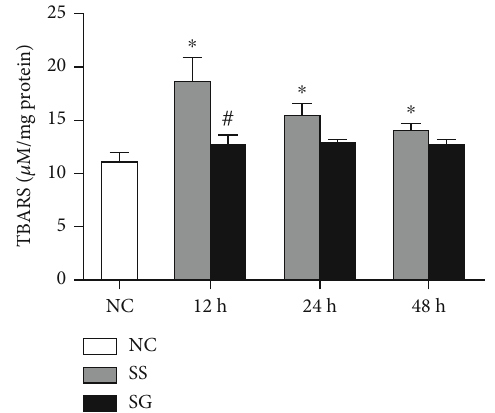
Figure 6: Thiobarbituric acid reactive substance (TBARS) in kidney tissues. NC: normal control; SS: sepsis group with saline; SG: sepsis group with glutamine. Values are expressed as the mean ± SEM . n = 8 for each group at 12, 24, and 48h after cecal ligation and puncture (CLP). Di ff erences between 2 sepsis groups at the same time point were analyzed by t -test. The comparison among NC and the sepsis groups at three di ff erent time points were analyzed by a one-way analysis of variance (ANOVA) followed by Tukey ’ s post hoc test. ∗ Signi fi cantly di ff ers from NC group; # signi fi cantly di ff ers from the SS group at the same time point ( p < 0 : 05